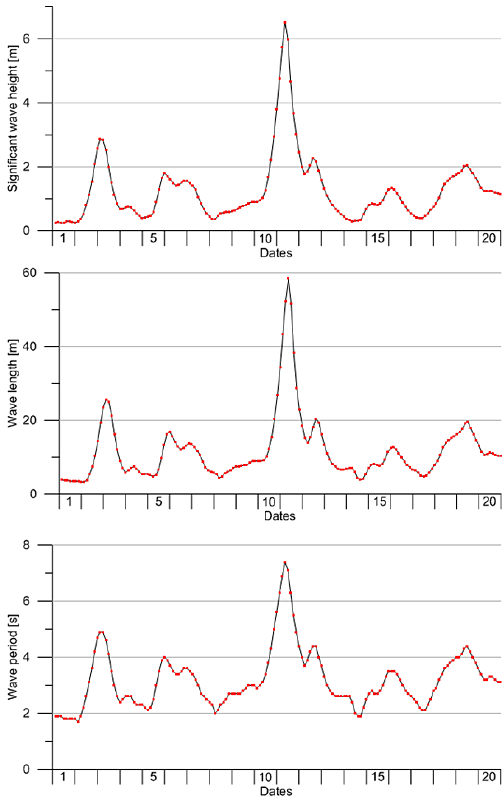
Figure 17. Time series of significant wave height, wave length and wave period at the point indicated on Fig. 16 in for the period be- tween 1 and 20 November